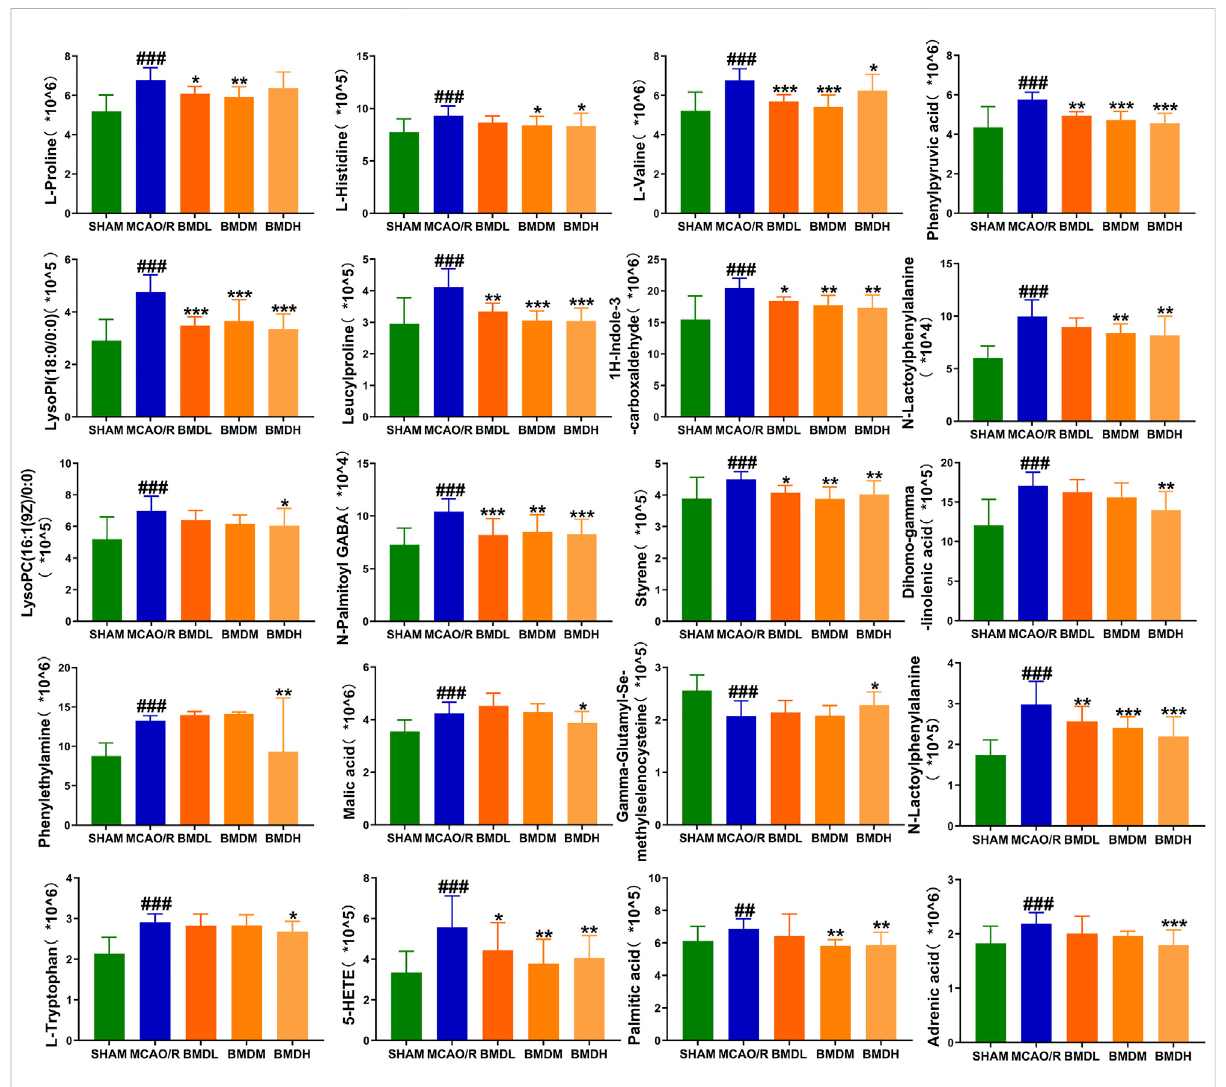
FIGURE 10 Differential metabolite changes in MCAO/R with BMD intervention in the brain. All values were presented as the mean ± SD. *p < 0.05, **p < 0.01, ***p < 0.001 relative to the MCAO/R group; ## p < 0.01, ### p < 0.001 relative to the SHAM